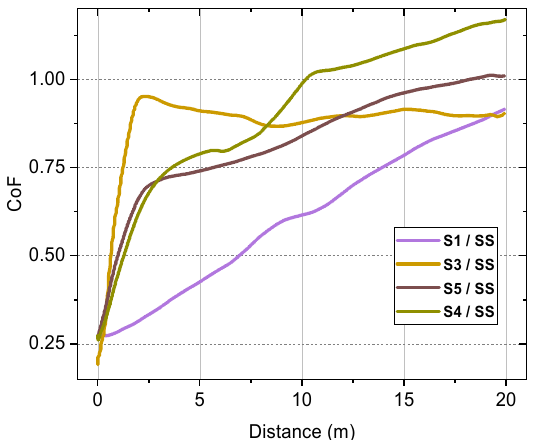
Figure 13. Friction coefficient versus running distance. Smoothed data lines by adjacent averaging function; S3 presented a stable CoF in comparison to S1 that had a progressive increase in relation to the sliding distance.